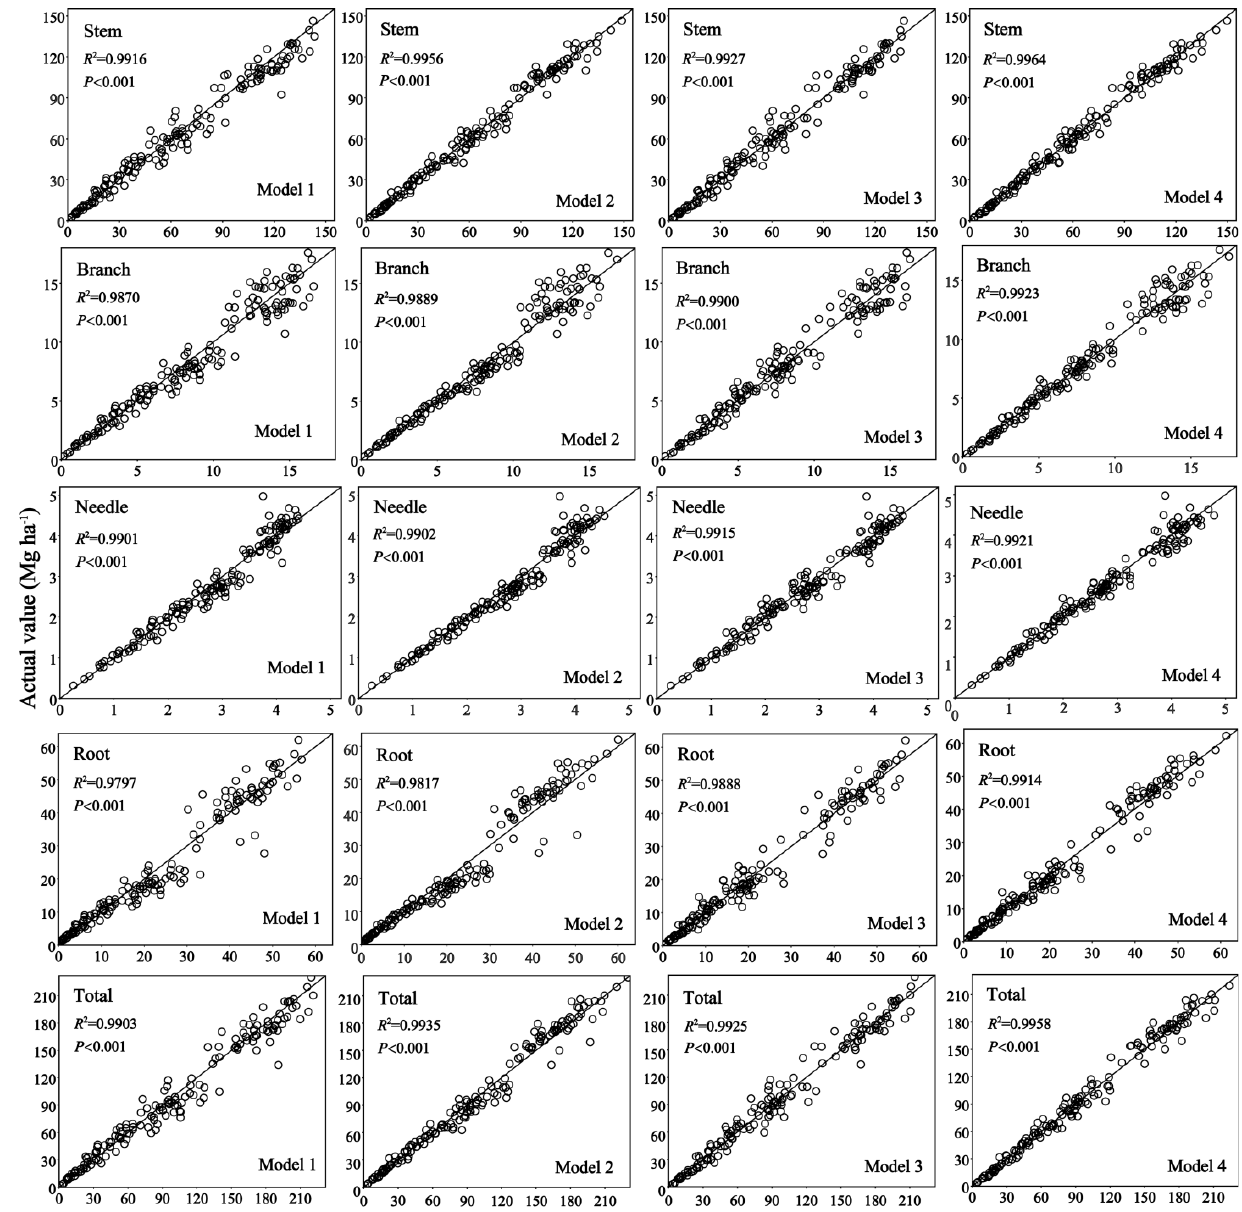
Figure 2. Scatter plots of the actual and predicted values calculated using stand biomass model type 1 (Model 1, M-1, Equation (4)), type 2 (Model 2, M-2, Equation (5)), type 3 (Model 3, M-3, Equation (6)), and type 4 (Model 4, M-4, Equation (7)), for each stand-level biomass component. The line is the regression line of the actual and predicted values. Line denotes 1:1 proportion.